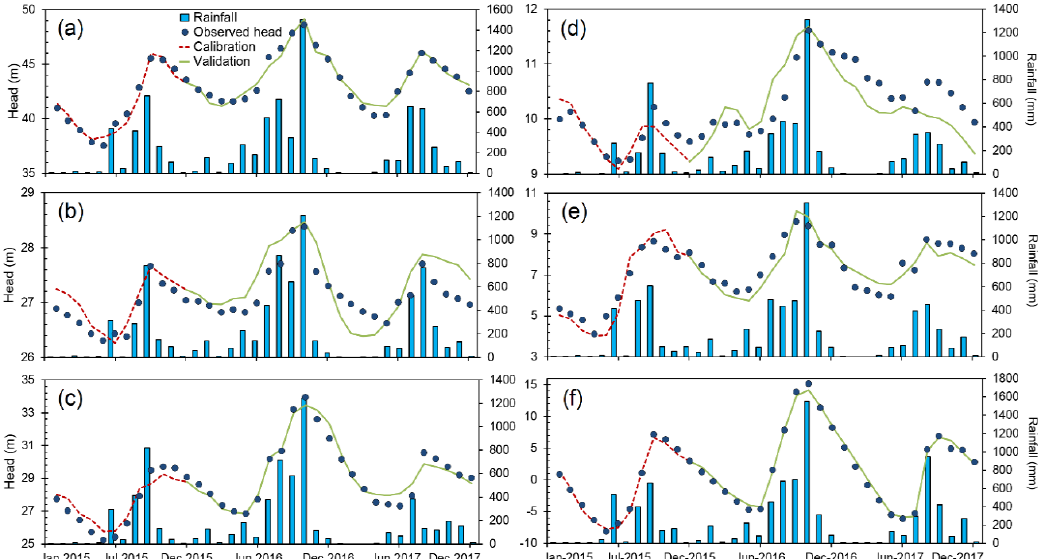
Figure 6. Comparison of observed (solid symbols) and simulated (dashed and solid lines) groundwater levels for the six selected wells. The monthly average rainfall data used the weather stations that are closest to the observation wells in the PPGB: ( a ) variations of groundwater levels at Jiyang station, ( b ) groundwater levels at Chiuju station, ( c ) groundwater levels at Jianxing station, ( d ) groundwater levels at Yongfang station, ( e ) groundwater levels at Kanding, and ( f ) groundwater levels at Fangliao station. Note that the dashed and solid lines represent the calibrated and validated results obtained from the groundwater model. See Figure 1 for the locations of the observation